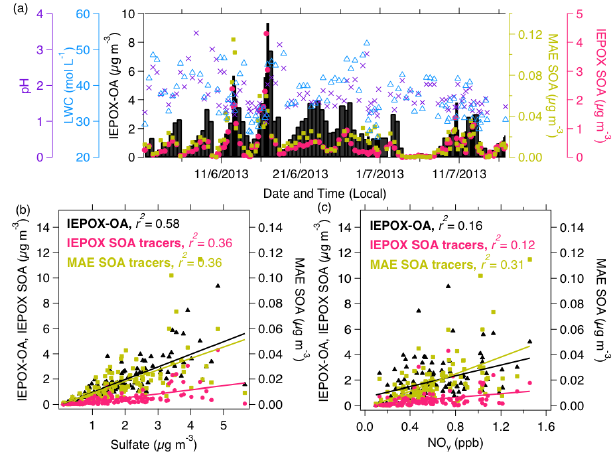
Figure 5. (a) Time series of IEPOX-OA factor (black bars; darker bars are intensive filter sampling periods), sum of IEPOX- derived (pink circle) and MAE-derived (yellow square) SOA trac- ers, aerosol pH (purple cross) and LWC (blue triangle) estimated by ISORROPIA-II model. Campaign average pH and LWC are 1.78 ± 0.53 and 38.71 ± 7.43molL − 1 , respectively. Correlation plots between IEPOX-OA, summed of IEPOX- and MAE-derived SOA tracers and (b) sulfate measurements by ACSM and (c) NO y measurements from